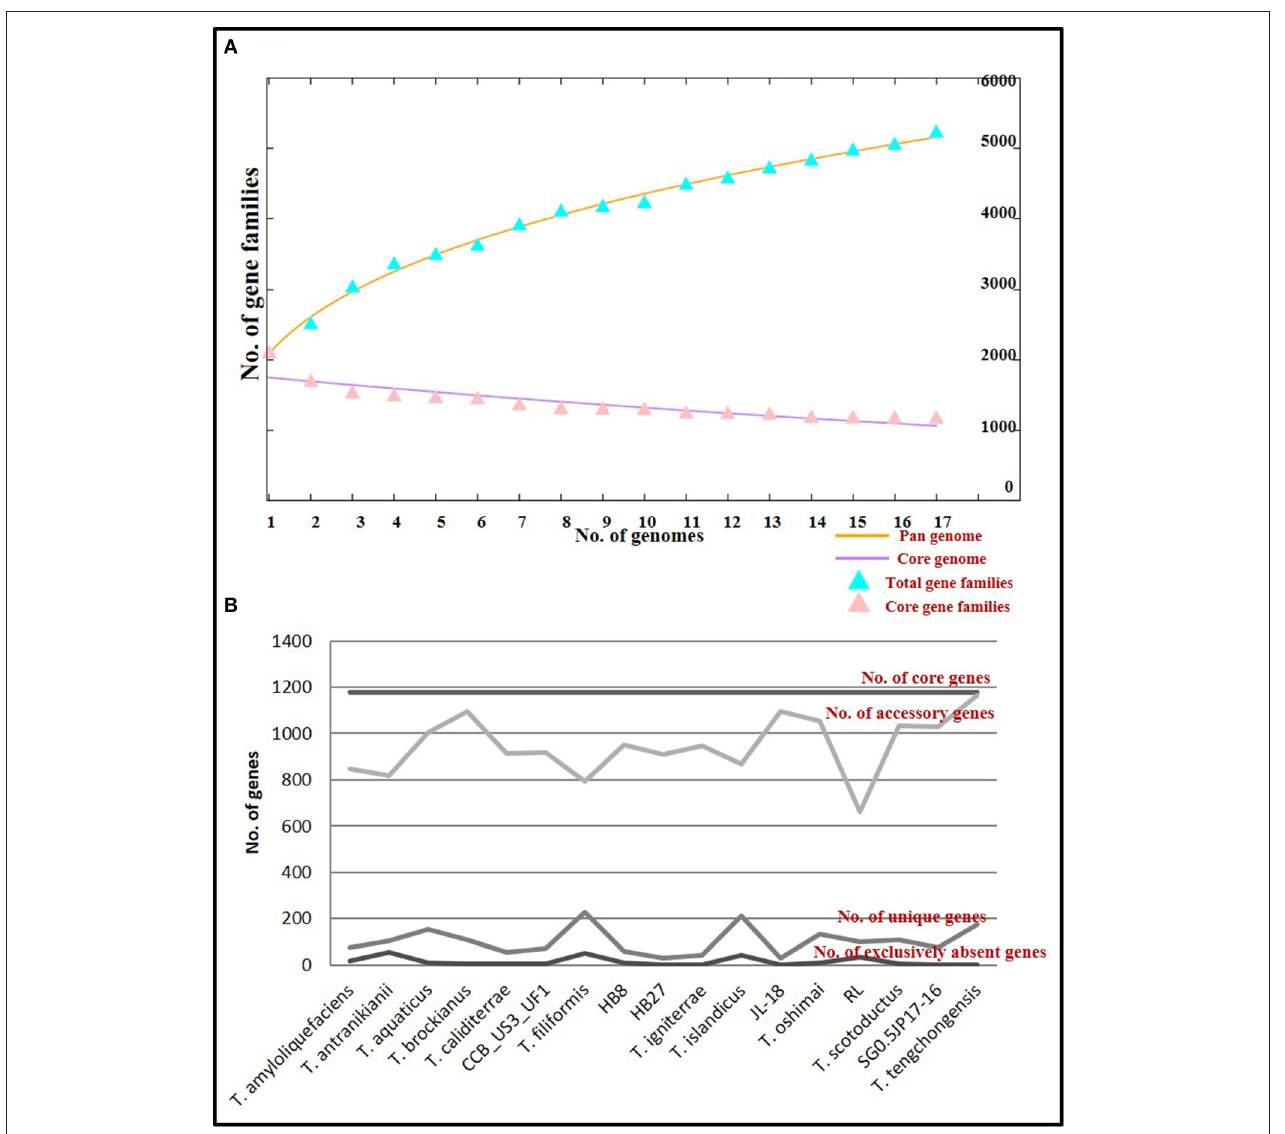
FIGURE 5 | Core and pan genome analysis of Thermus genus (A) Plot of pan and core genome. The plot represents a stabilized core structure but an open pan-genome; (B) Graph showing the number of core genes, accessory genes, unique genes and exclusively absent genes in all genomes under